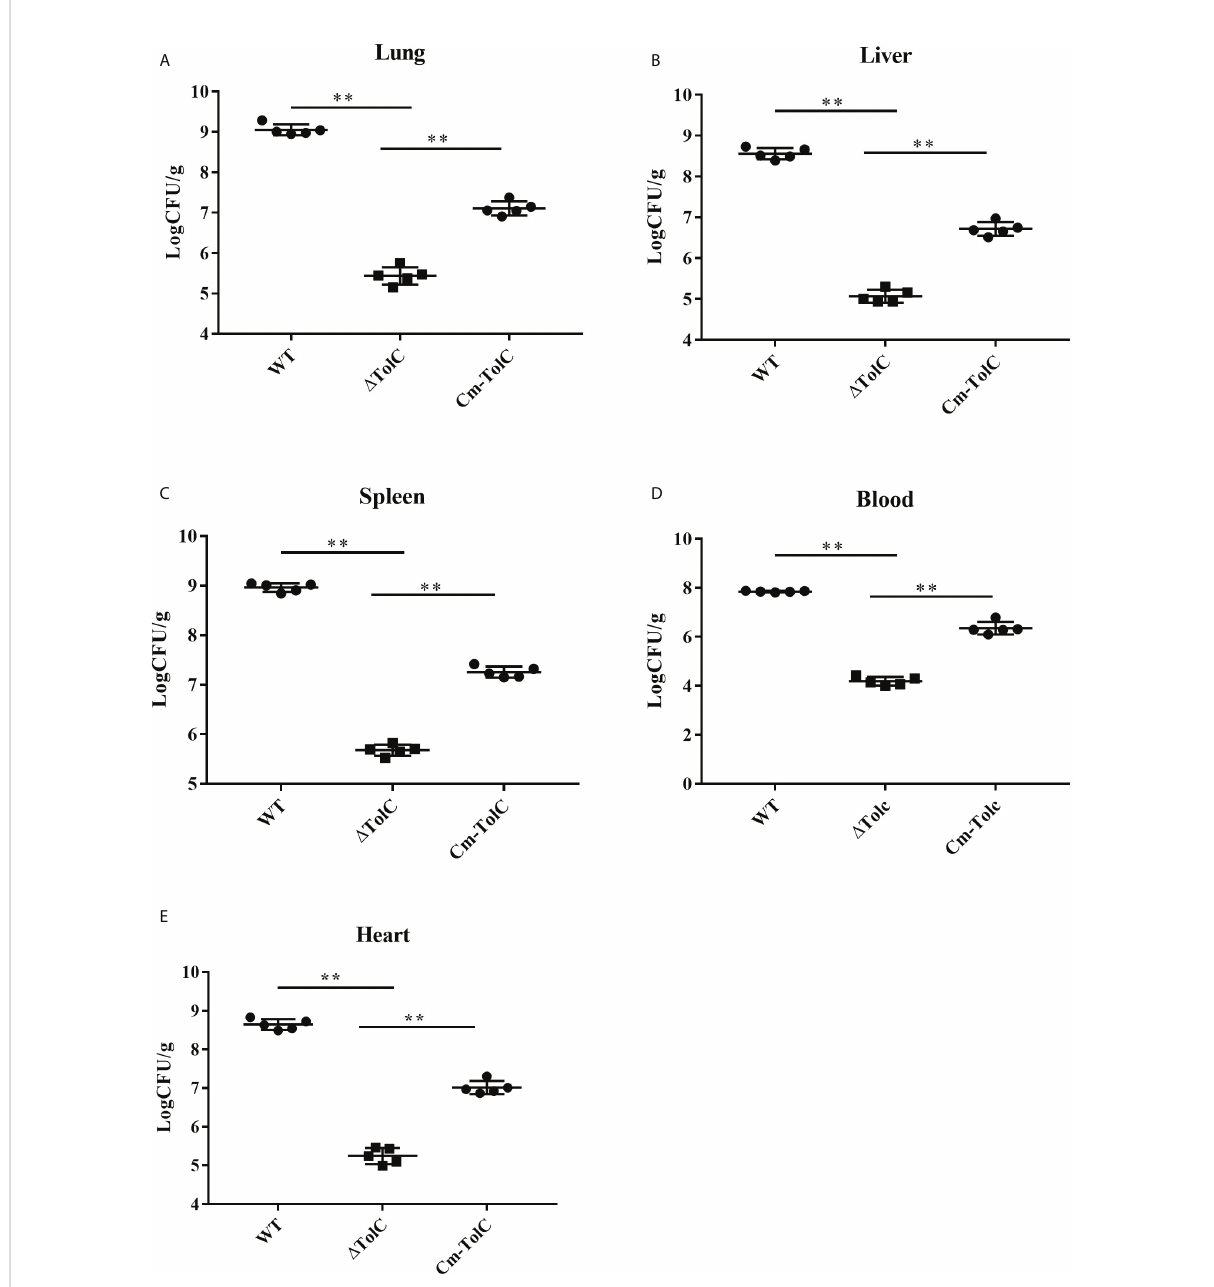
FIGURE 3 Distribution of bacteria in different organs from mice infected intraperitoneally with the WT, D TolC, and Cm-TolC strains. Bacterial loads in the lung (A) , live (B) , spleen (C) , and heart (D) are expressed as CFU per 0.15 g of tissue, and in the blood (E) as CFU per milliliter. Statistical analyses were performed by a repeated measures test with a two-tailed unpaired t-test. Statistically signi fi cant difference is indicated as ** p ≤